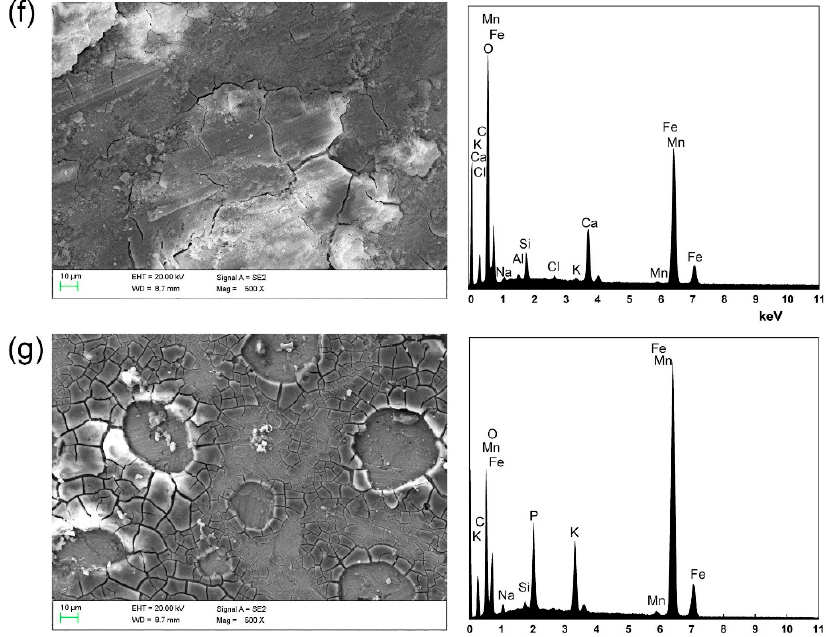
Figure 6. SEM and EDS analysis of the specimens coated with MCIs after varying degrees of chloride erosion; ( a ) A0-steel bar, ( b ) B-steel bar, ( c ) A1-steel bar, ( d ) A2-steel bar, ( e ) A3-steel bar, ( f ) A4-steel bar, ( g ) A5-steel bar.